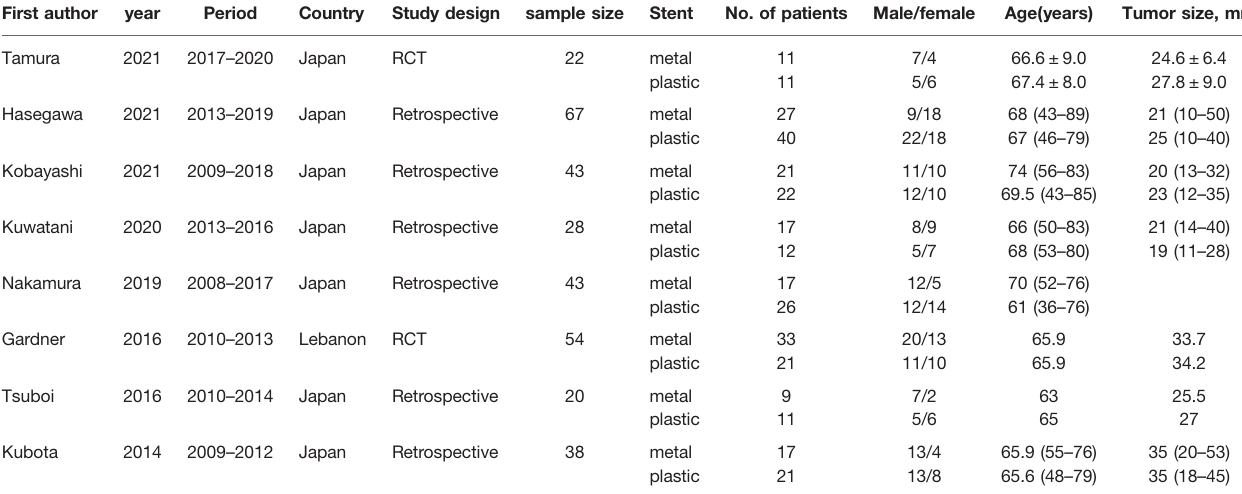
TABLE 1 | Characteristics of the eight studies included in the systematic review and